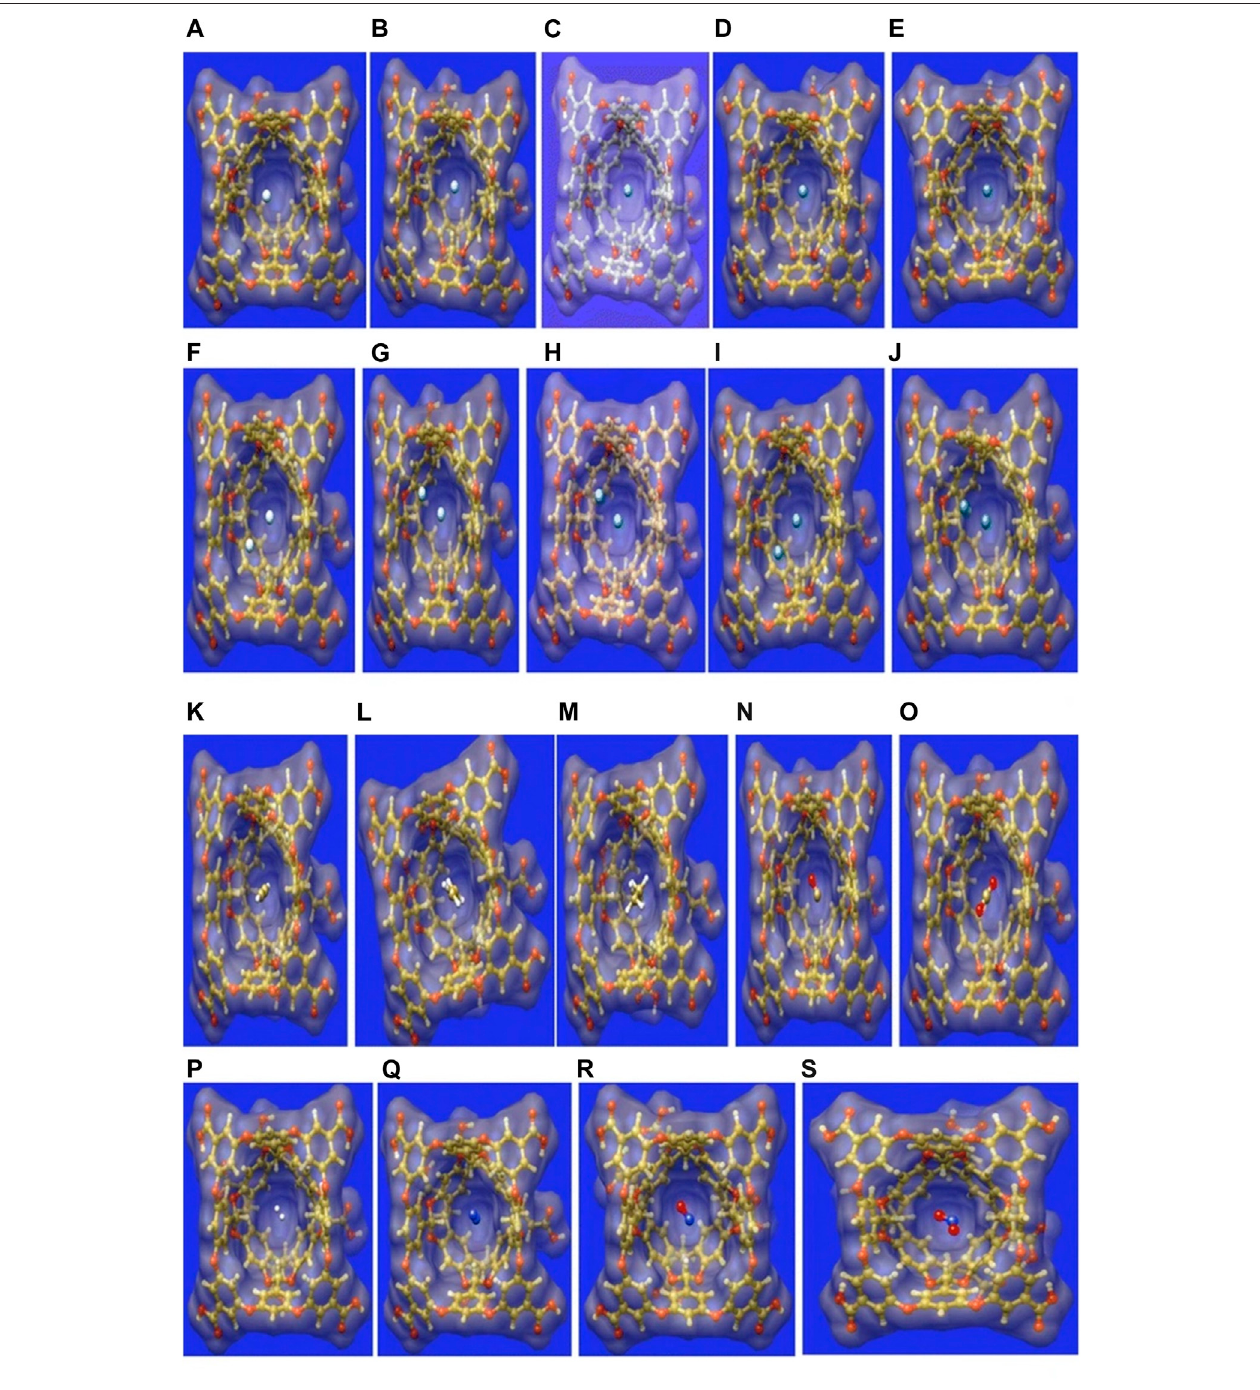
FIGURE 6 | The surface representation of the optimized geometries of the guest encapsulated OA, where the guests are: (A) He, (B) Ne, (C) Ar, (D) Kr, (E) Xe, (F) He 2 , (G) Ne 2 , (I) Ar 2 , (J) Kr 2 , (K) Xe 2 , (L) C 2 H 2 , (M) C 2 H 4 , (N) C 2 H 6 , (O) CO, (P) CO 2 , (Q) H 2 , (R) N 2 , (S) NO, and (T) NO 2 . (Adapted from Chakraborty et al., 2016 with permission from Theoretical Chemistry Accounts, Springer Nature. Copyright© 2016, Springer-Verlag Berlin Heidelberg.).